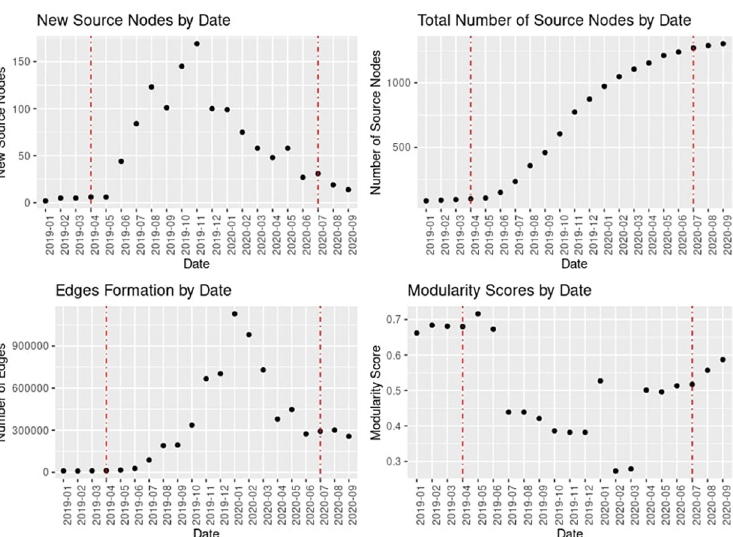
Fig 2. Dynamics of network development. Red lines correspond to: the announcement of the Anti-Extradition Bill in the end of March 2019, and the enactment of the National Security law in July 2020.